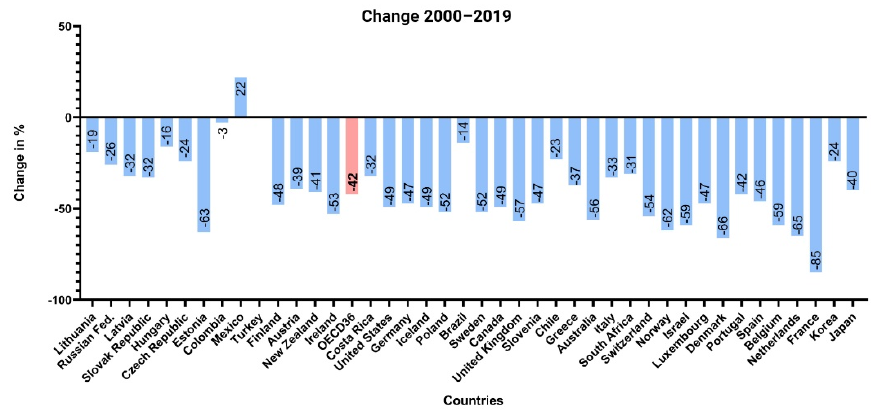
Figure 1. Acute myocardial infarction and other ischemic heart disease mortality change from 2000–2019 (Taken and modified from: Health at a Glance 2019–© OECD 2019) [35].